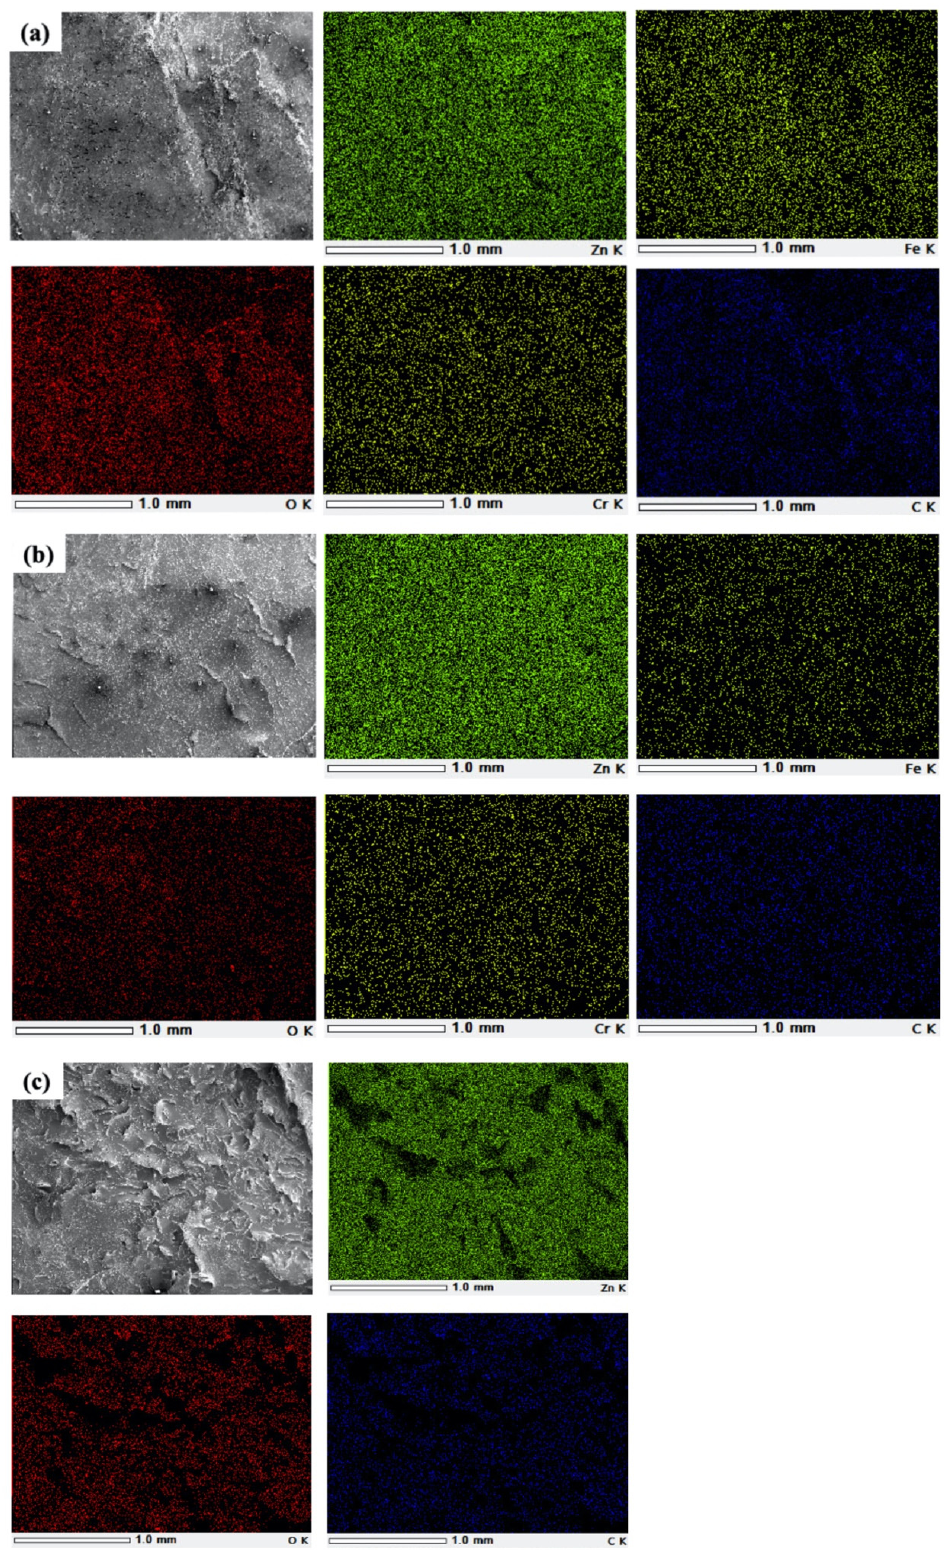
Figure 8. EDS map analysis: ( a ) 35 s sample, ( b ) 40 s sample, and ( c ) 45 s sample.